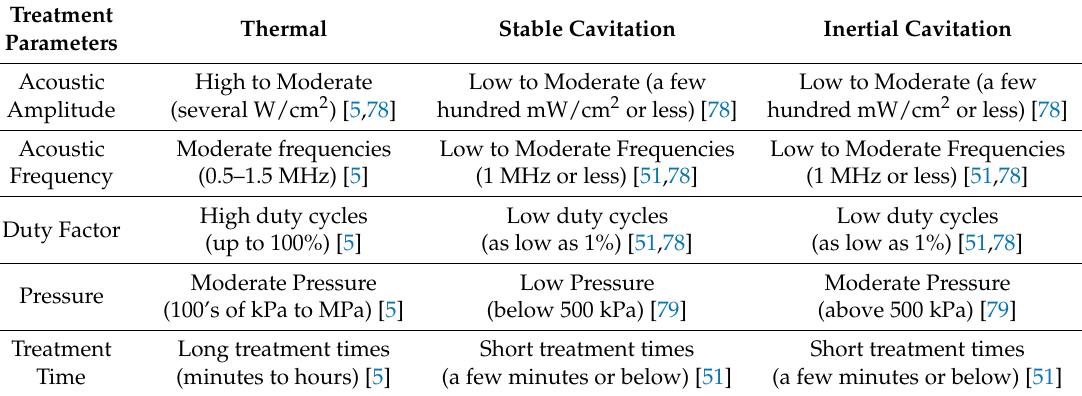
Table 1. Common parameters used to induce thermal, stable cavitation, or inertial cavitation in vivo using